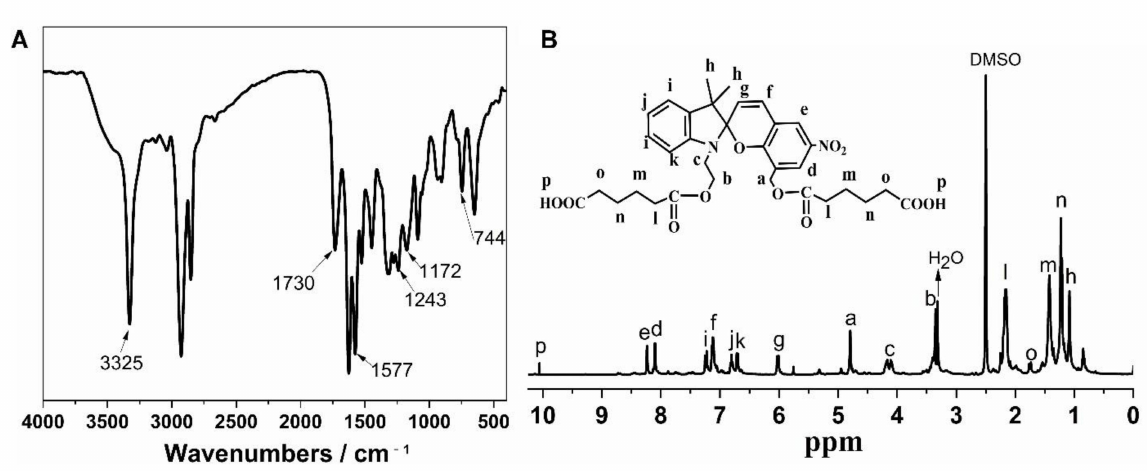
Figure 1. ( A ) FTIR spectrum and ( B ) 1 H NMR spectrum of carboxyl-terminated spiropyran (HOOC-SP-COOH).